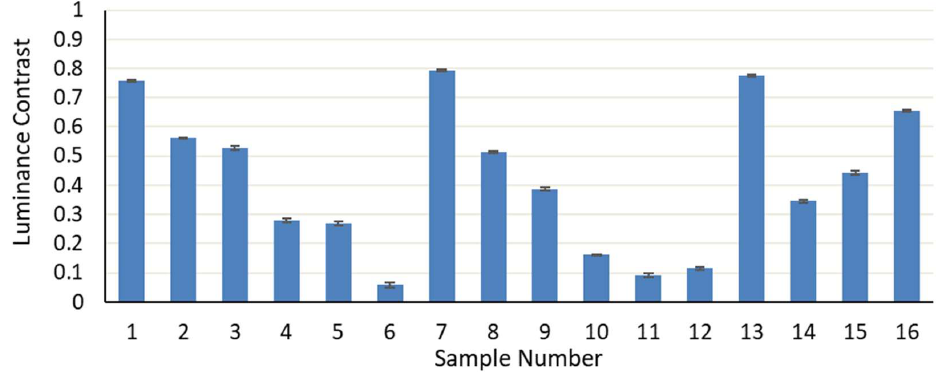
Figure 9. Luminance contrast measurement results.